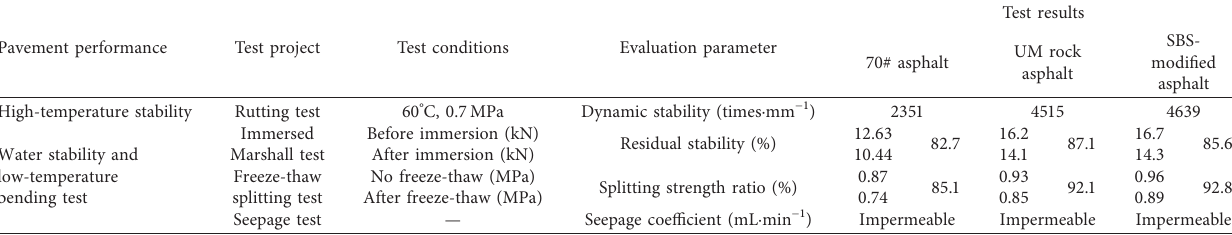
Table 10: Pavement performance of asphalt